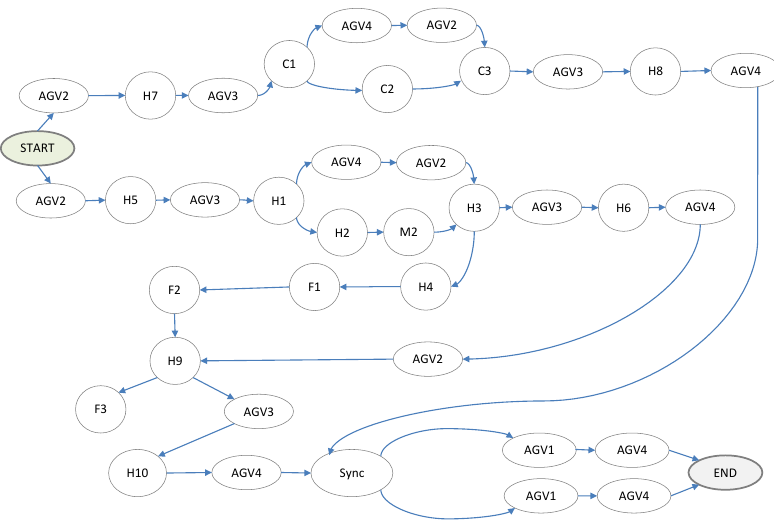
Figure 10. Schematic graph of the demonstrated use-case scenario.